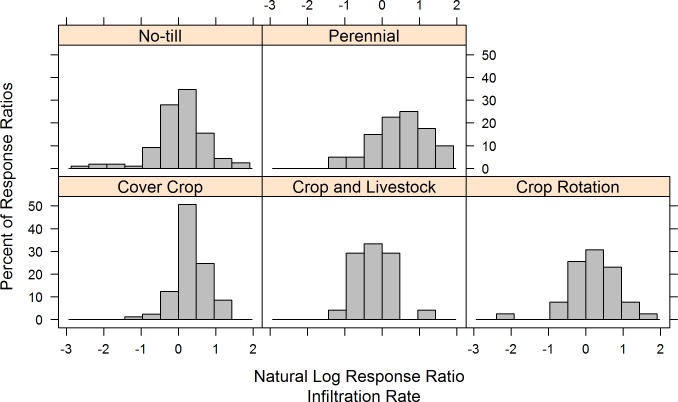
Publication bias analysis using histograms of response ratios.Histograms created using the methodology suggested by Rosenberg et al. (2000) [48]. Normal distributions indicate that publication bias was not likely a factor in study results (i.e. there was not a bias against publishing experiments that did not have significant effects).